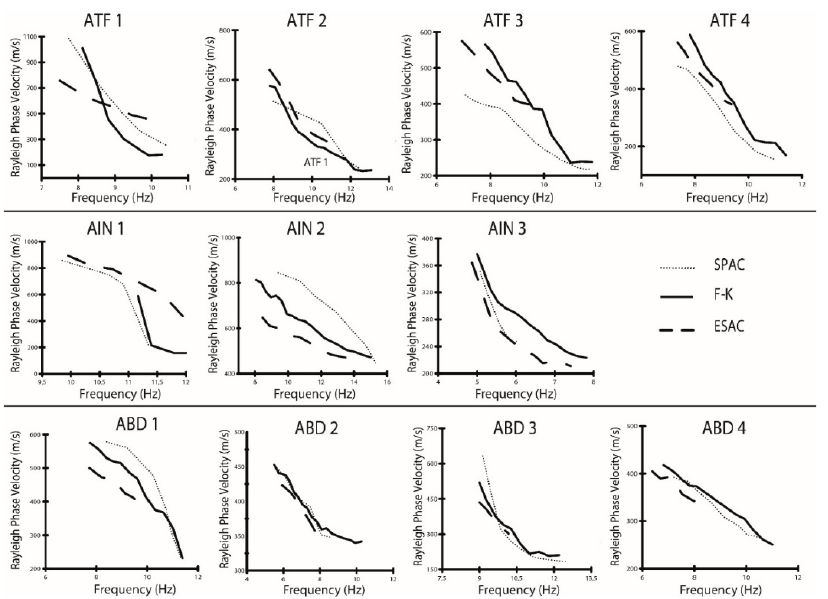
Figure 4. Rayleigh wave dispersion curves obtained from the F ‐ K, SPAC, and ESAC methods.